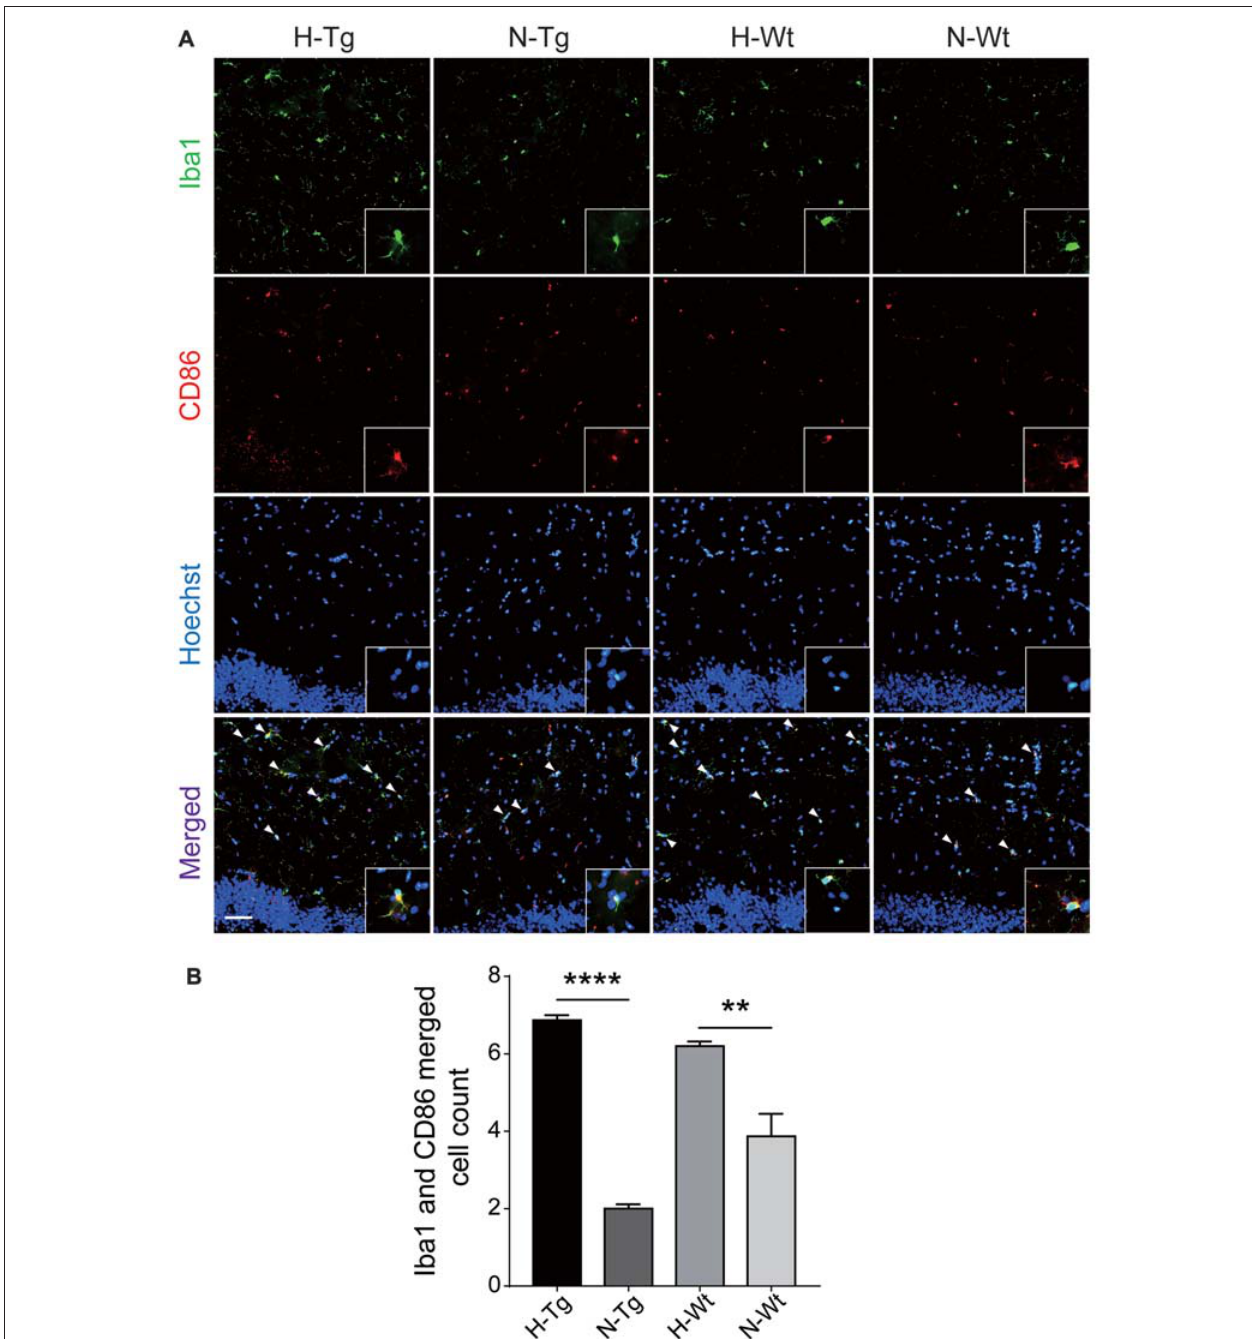
FIGURE 3 | Double immunostaining of cluster of differentiation 86 (CD86; M1 marker) and Iba1 positive microglial cells in hippocampus. CD86 (red) and Iba (green) co-stained microglial cells (yellow, arrow head) were increased significantly in H-Tg and H-Wt groups vs. N-Tg and N-Wt groups, respectively (A,B) . Scale bar: 50 µ m, n = 3 in each group. Data were the mean ± SEM values. ∗∗ p < 0.01, ∗∗∗∗ p < 0.0001 by one-way ANOVA.